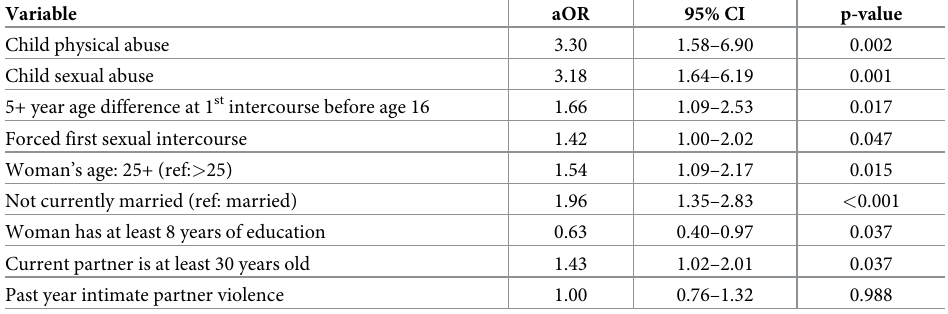
Table 3. Multivariate logistic regression showing factors associated with HIV after adjusting for demographic fac- tors and partner violence.